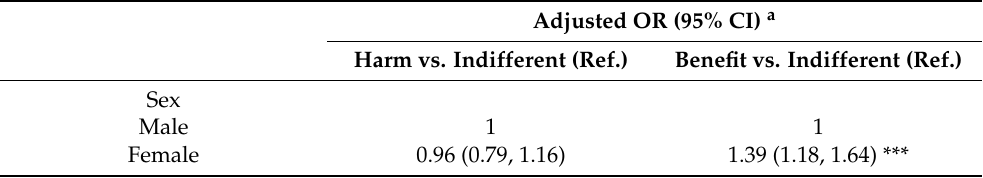
Table 5. Associations of socio-demographic characteristics with identified subgroups of perceived harms and benefits (N = 4520). Adjusted OR (95% CI) a Harm vs. Indifferent (Ref.) Benefit vs. Indifferent